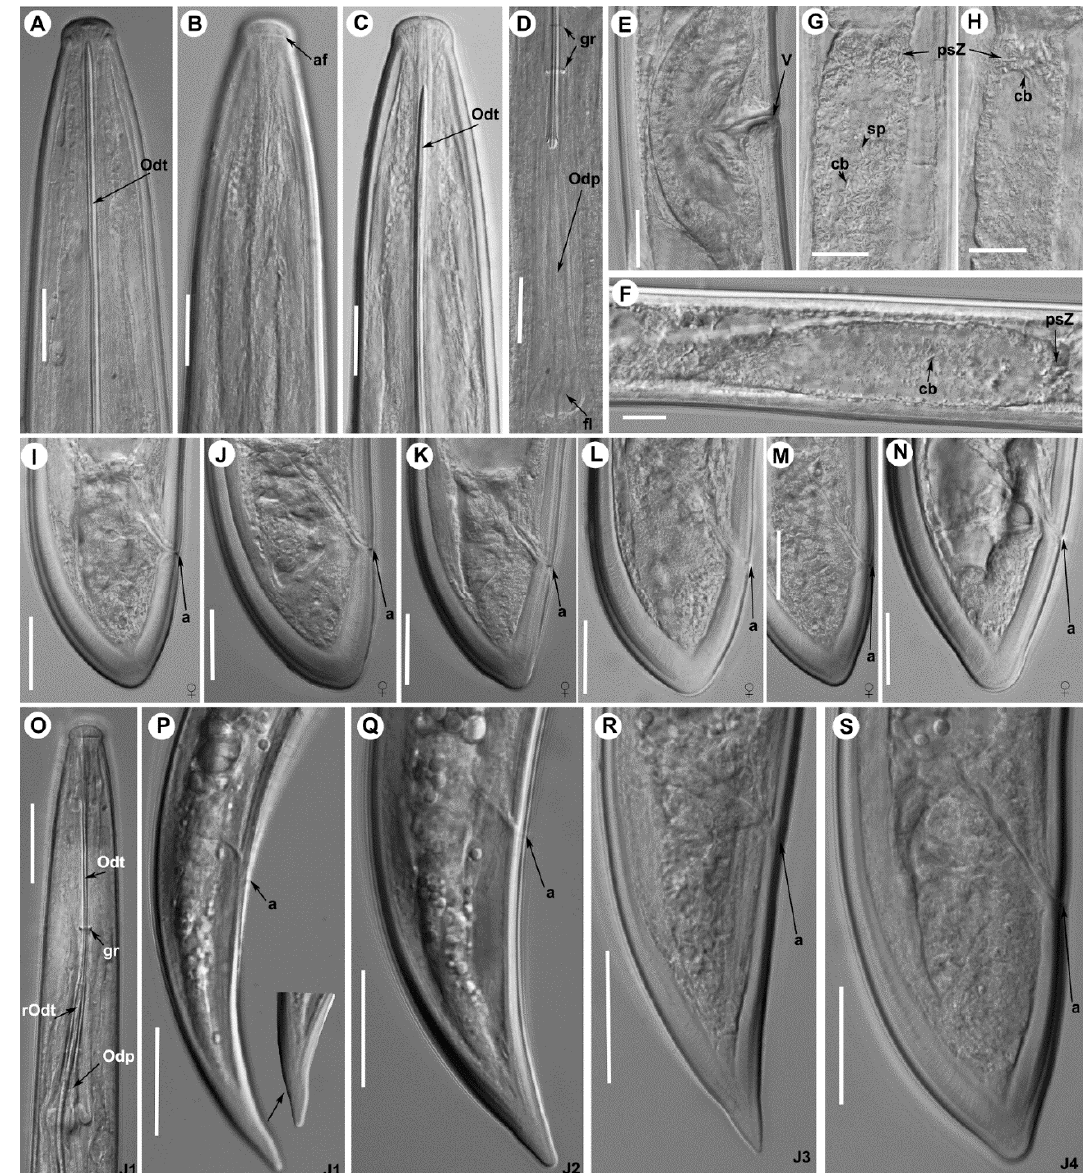
Figure 8. Light photomicrographs of Xiphinema malaka sp. nov. females holotype and paratypes: ( A ), anterior region holotype; ( B , C ) anterior regions paratypes; ( D ), detail of odontophore and guiding ring in holotype; ( E ), vulval region; ( F – H ), detail of female genital track showing Z-differentiation in holotype; ( I ), tail region of holotype; ( J – N ), tail region in paratypes; ( O ), detail of first-stage anterior region; ( P – S ), tail region of 1st, 2nd, 3rd and 4th stage juveniles. Abbreviations: a = anus; af = amphidial fovea; cb = crystalloid bodies; fl = odontophore flanges; gr = guiding ring; odp = odontophore; odt = odontostyle; psZ = pseudo-Z organ; rodt = replacement odontostyle; sp = spine; v = vulva. Scale bars: 20 μ m.